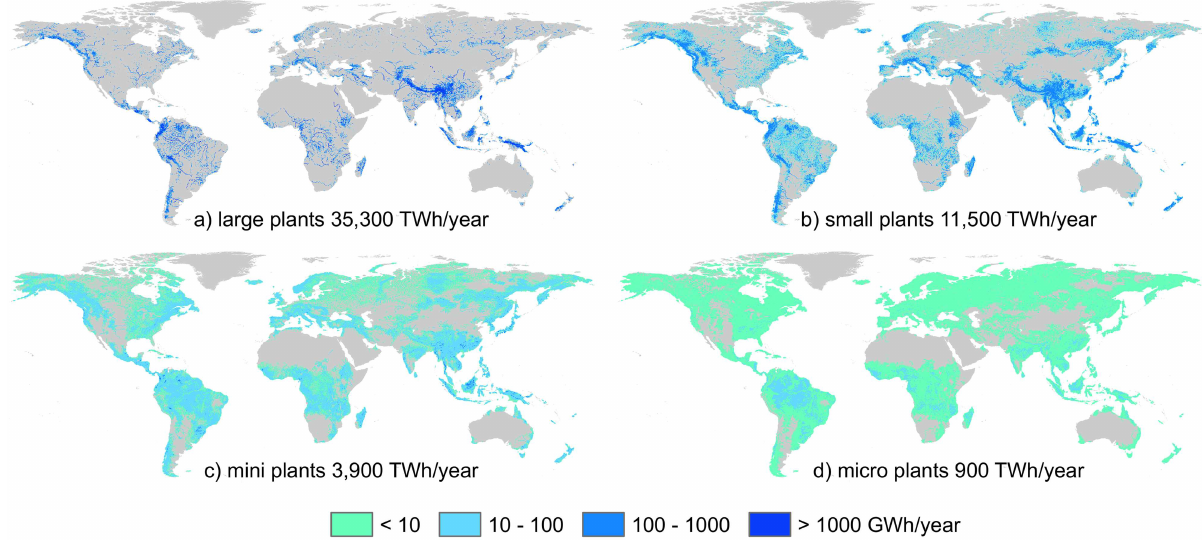
Fig 3. Global number of gross potential hydropower locations of a certain size. Total numberof locationsfound is 1.2 × 10 7 . For Micro: N = 8.0 × 10 6 , Mini: N = 2.7 × 10 6 , Small: N = 8.8 × 10 5 , Large: N = 1.6 × 10 5 . The empiricalfits allow the computationof the numberof locationsin a certain range while choosingan arbitrary bin size. The numberof potentialpico hydropower locationswouldbe larger if computations were performed on a finer-resolution grid. For the separationbetweenthe classes, a capacity factor of 0.5 was used.